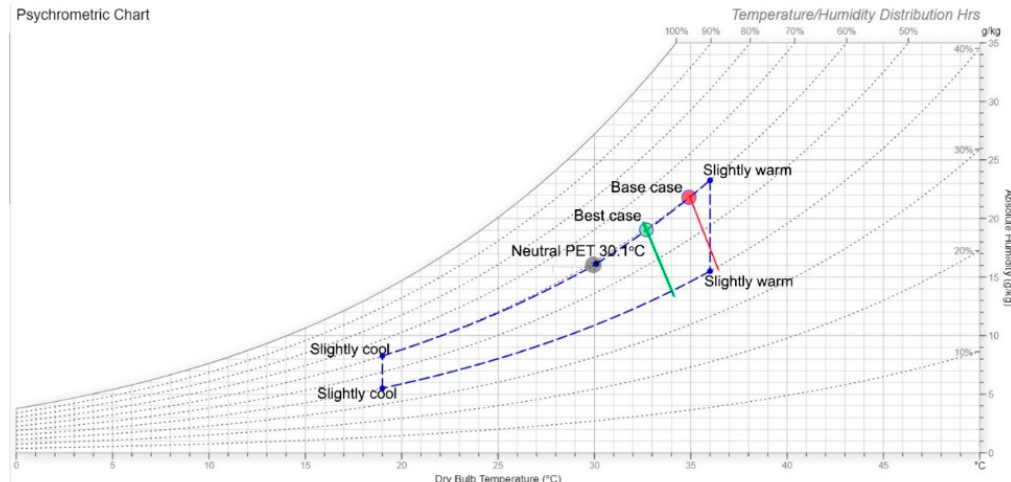
Figure 14. Case study psychrometric chart for outdoor thermal comfort acceptable range and neutral PET according to the estimates from the in situ field measurements and the subjective questionnaire, in addition to the PET obtained from the CFD modelled cases.